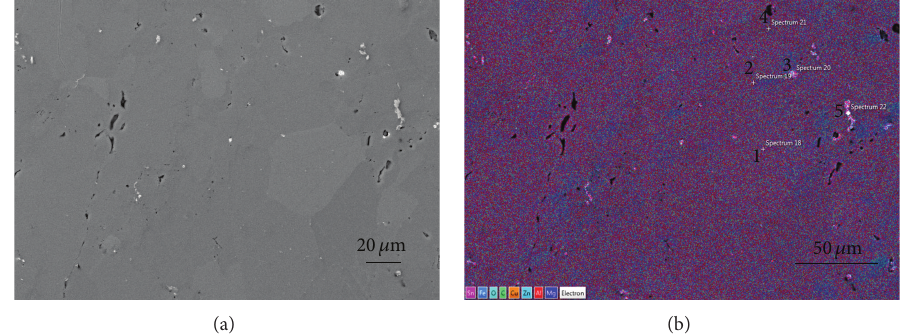
Figure 9: (a) SEM image of Alumix 431D after T6 heat treatment and (b) selected area and locations for mapping and point elemental analysis by EDS numbered 1–5.